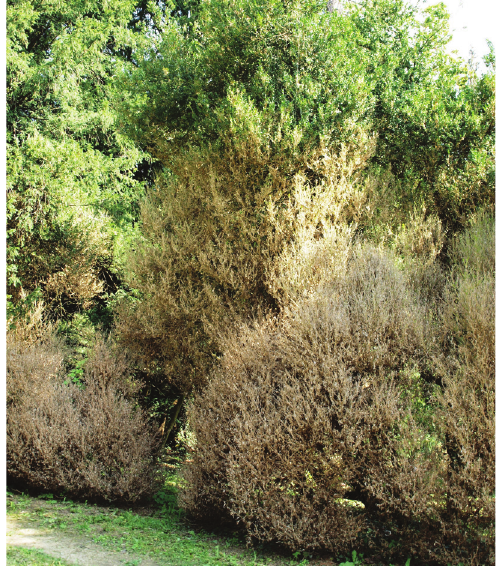
FIGURE 1. Defoliated box plants ( Buxus sempervirens ) in Arboretum Vinica, Croatia (25 September